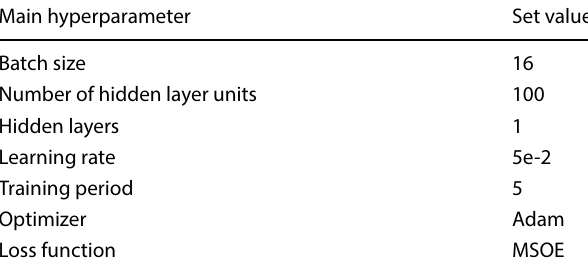
Table 5 Main hyperparameter settings